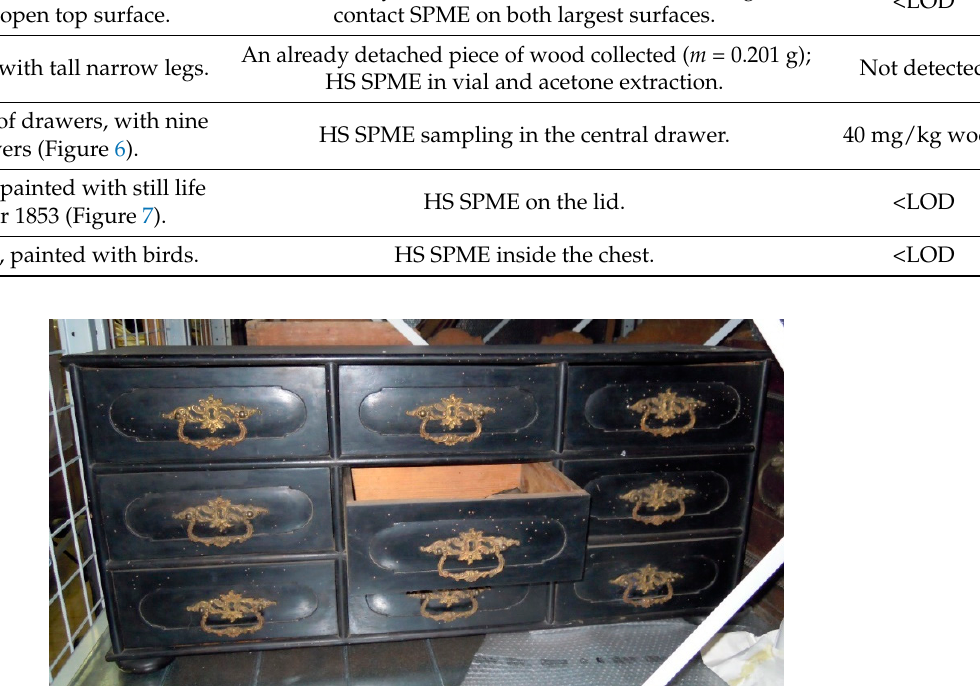
Figure 6. HS SPME sampling was done in the central drawer of OBJ3. Figure 6. HS SPME chromatogram of OBJ3: PCP, lindane and dibutyl phthalate (DBP) were identified. Polymers 2021 , 13 , x FOR PEER REVIEW